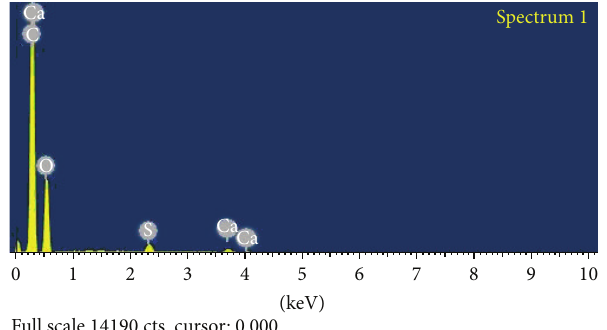
Figure 3: SEM image of CCRWSD.